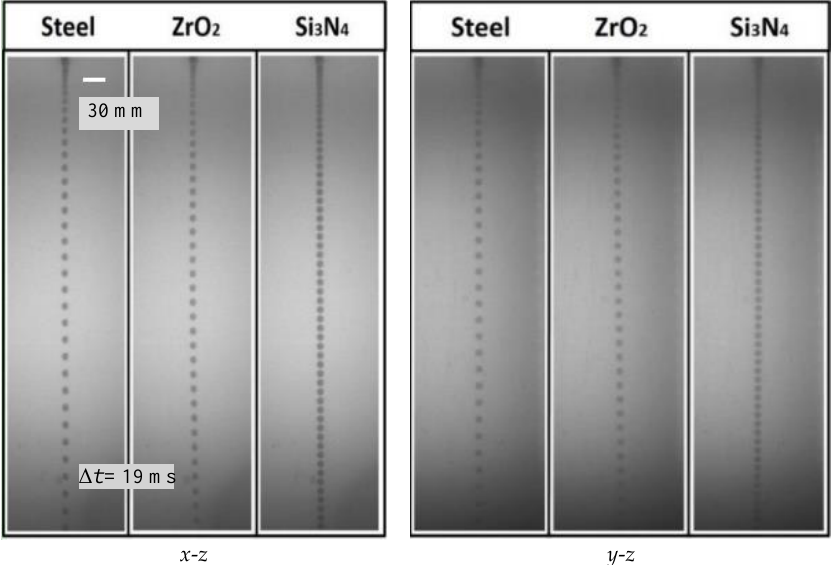
Figure 9. Settling behaviors of single particle. The time interval between adjacent particles is 19 ms.